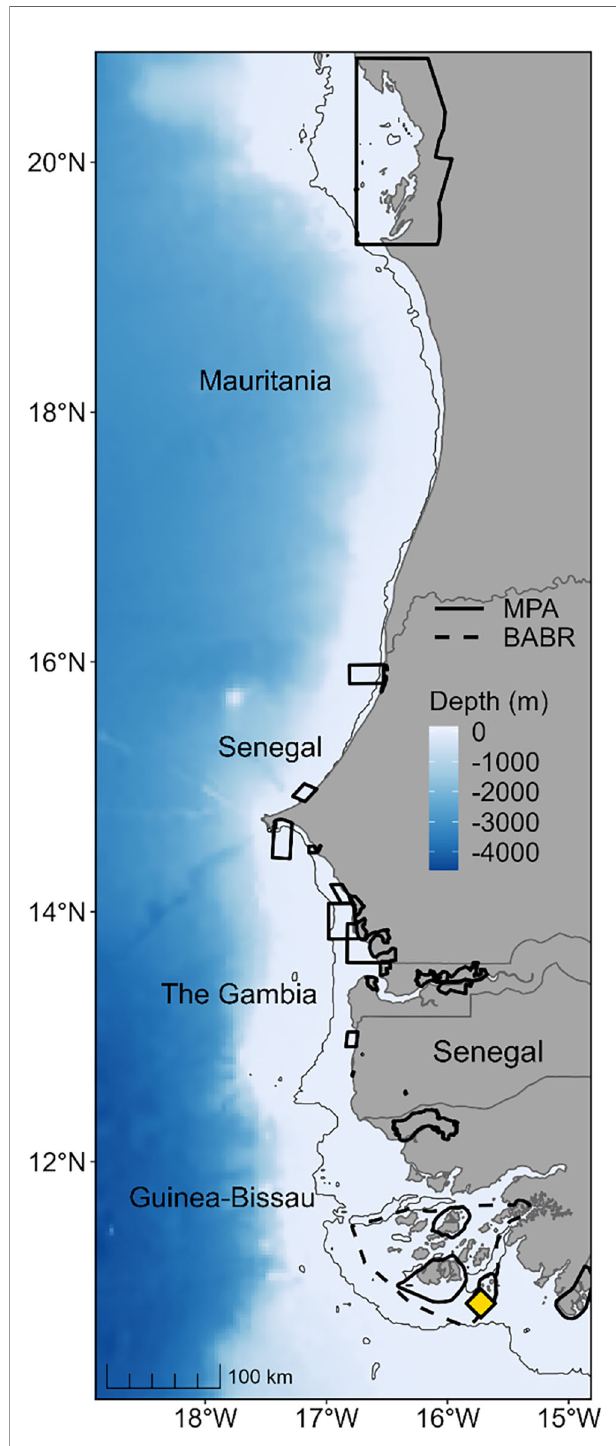
FIGURE 1 | Map of West Africa from the north of Guinea in the south to Mauritania in the north. Solid black polygons show the limits of existing marine protected areas (MPAs). Dashed black line shows the limit of the UNESCO Bolama-Bijago ́ s Archipelago Biosphere Reserve. Yellow diamond indicates the main nesting site of the study population of green turtles ( Chelonia mydas ); Poilão Island. The bathymetry is shown in a scale of blue, and a thin grey line is the 15 m depth